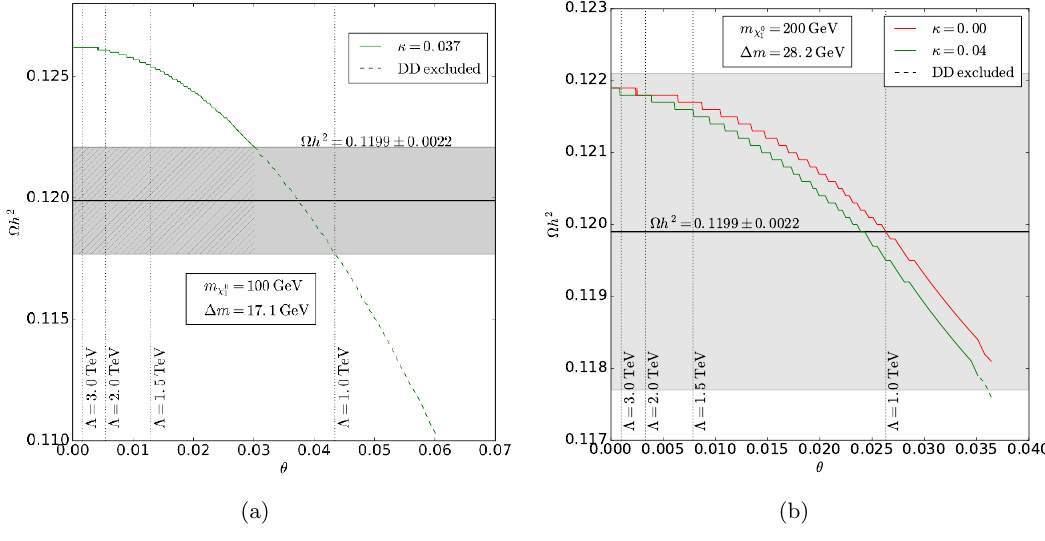
Figure 6 . Same as (cid:12)gure 3 but for the quintuplet model, with appropriately modi(cid:12)ed mass splittings (cid:1) m